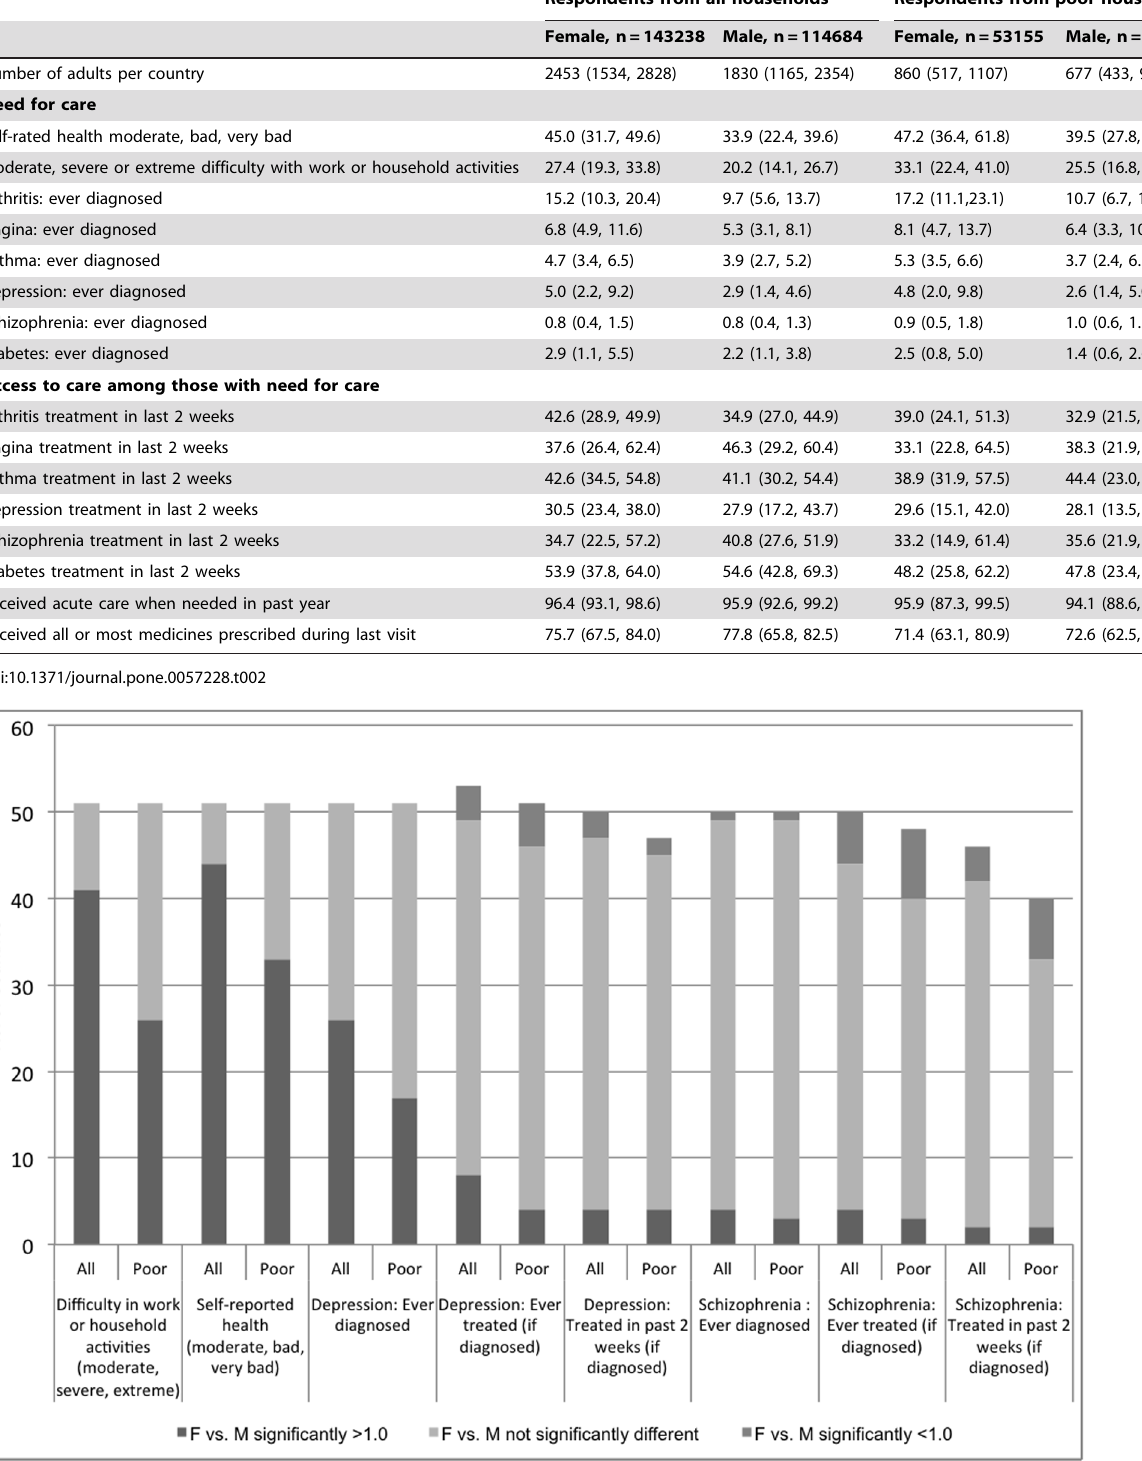
Respondents from all households Respondents from poor households Female, n=143238 Male, n=114684 Female, n=53155 Male, n=41810